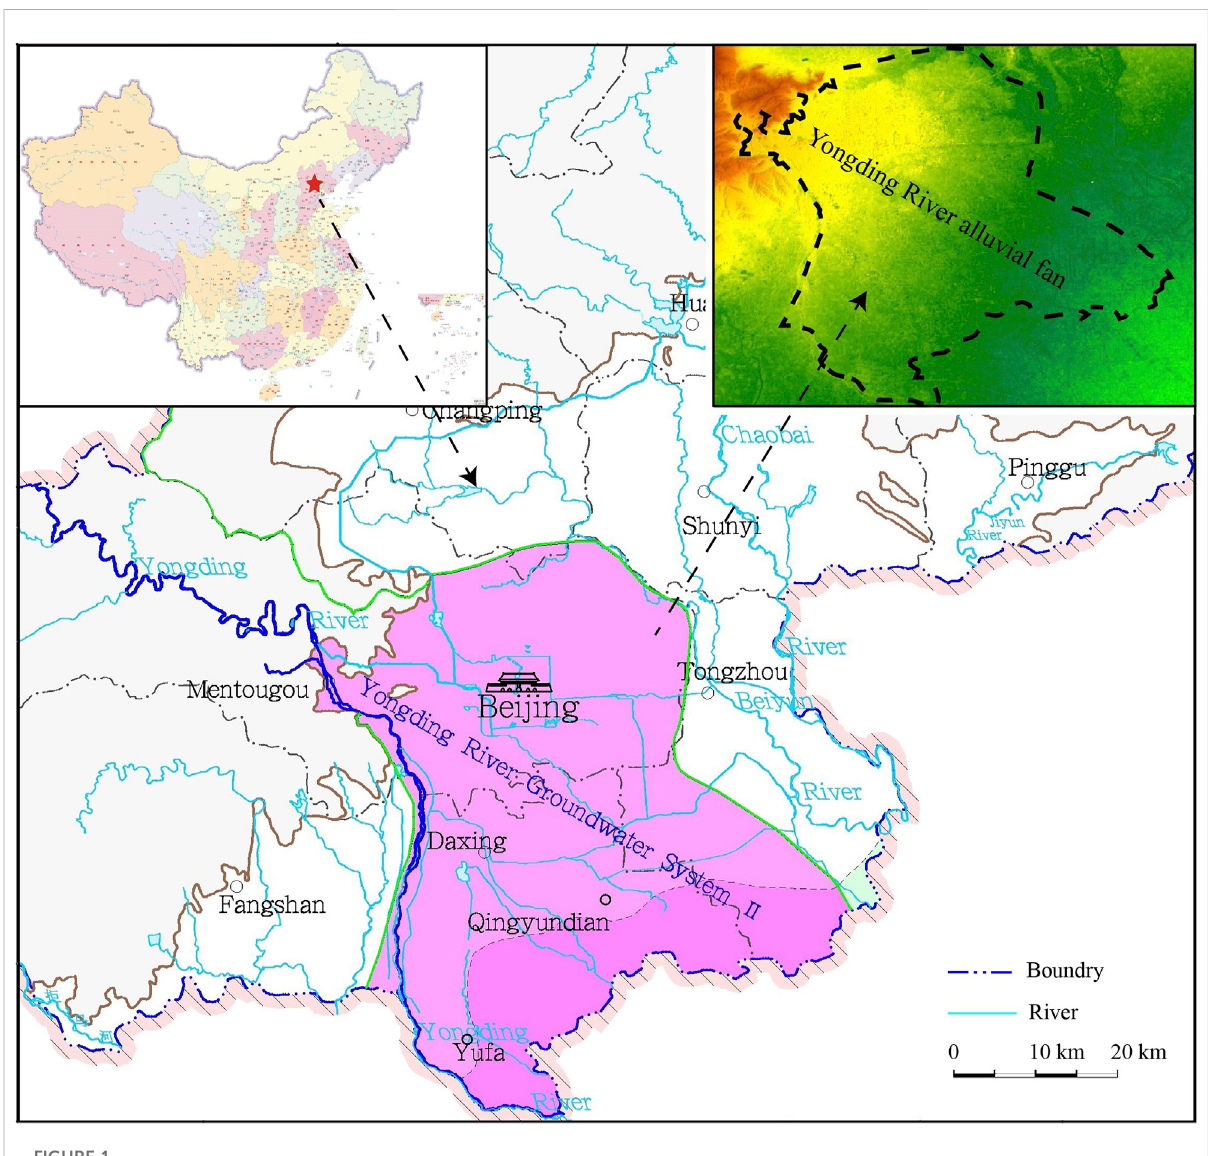
FIGURE 1 Schematic map of the YDR groundwater system in